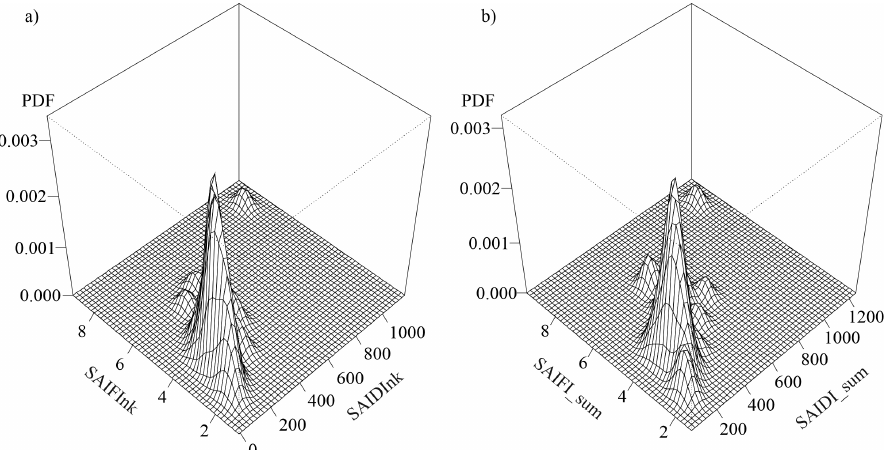
Figure 5. Two-dimensional density function obtained by means of KDE function for: ( a ) sum of unplanned outages and catastrophic outages (SAIFInk, SAIDInk), ( b ) sum of planned outages and unplanned outages and catastrophic events (SAIFI_sum,